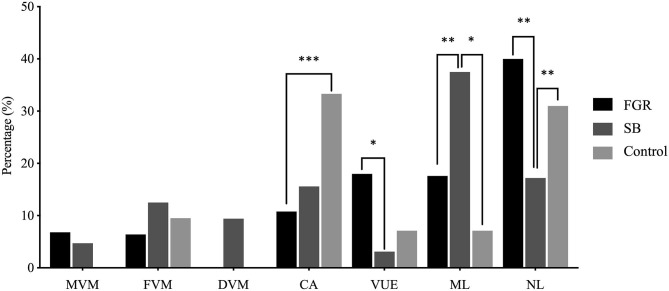
Distribution of placental lesions across the FGR, SB and control cohorts. Percentages of specific lesions, and comparison between the FGR (n = 250), SB (n = 64), and control (n = 42) cohort with the Chi-square test. No cases of DVM as a single lesion were present in the FGR and control cohorts. No cases of MVM as a single lesion were present in the control cohort. *p < 0.05, **p < 0.01, ***p < 0.001 (p-values adjusted using Bonferroni correction).